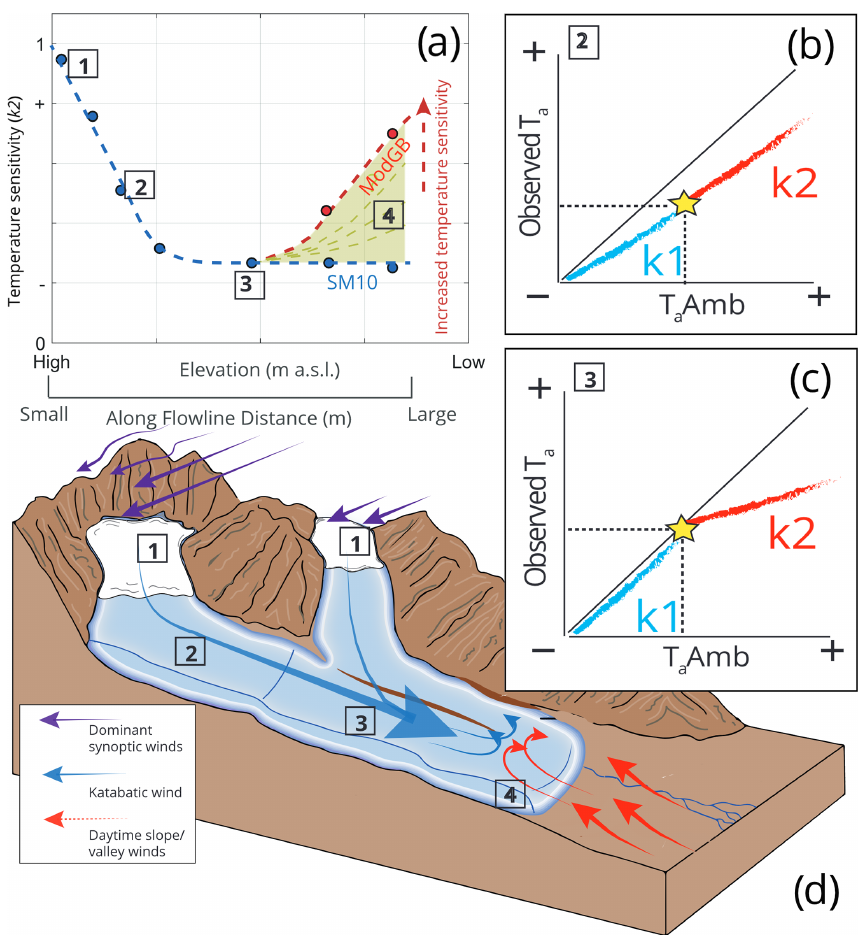
Figure 1. A schematic diagram to describe the temperature sensitivity of on-glacier air temperature ( T a ) to the extrapolated ambient temper- ature ( T a Amb) at given elevations/flowline distances on a mountain glacier. Points 1–4 indicate locations of interest that are linked between panels. Panel (a) indicates the along-flowline k 2 temperature sensitivities to T a Amb, considering the differences represented by the models of SM10 and ModGB for glacier termini (see text). Panels ( b ) and ( c ) represent the differences of k 1 (blue) and k 2 (red) sensitivities observed in the data at different theoretical locations on the glacier, the latter of which shows the theoretical parameterisation presented by Shea and Moore (2010). The yellow stars indicate the calculated threshold for katabatic onset ( T ∗ in the text). Panel (d) represents an idealised case of katabatic and valley/synoptic wind interactions that potentially dictate the along-flowline structure of on-glacier temperature sensitivity and thus T a